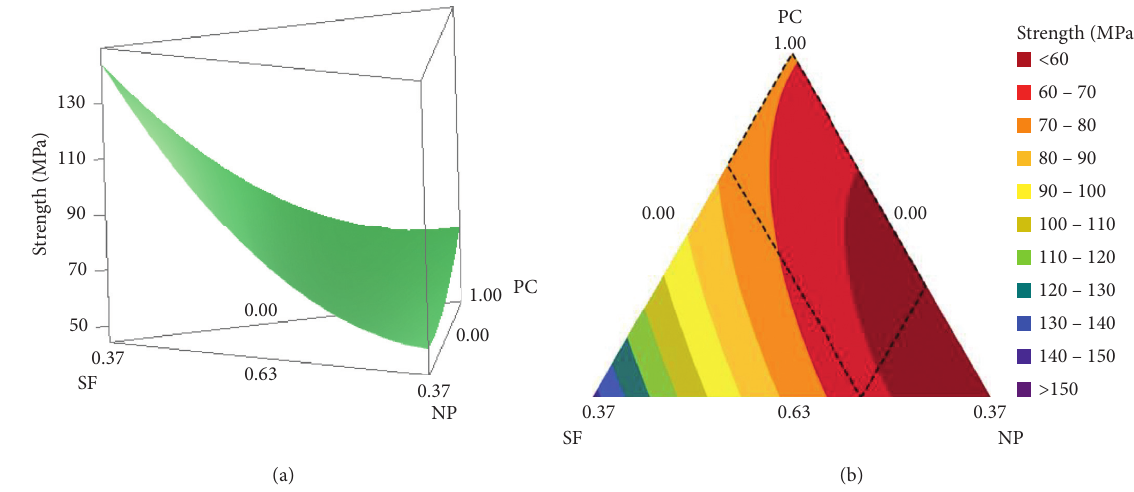
Figure 9: Strength isoresponse of concrete that incorporates a blend of binders ( ( w / b ) � 0.40). (a) Surface. (b) Contours.